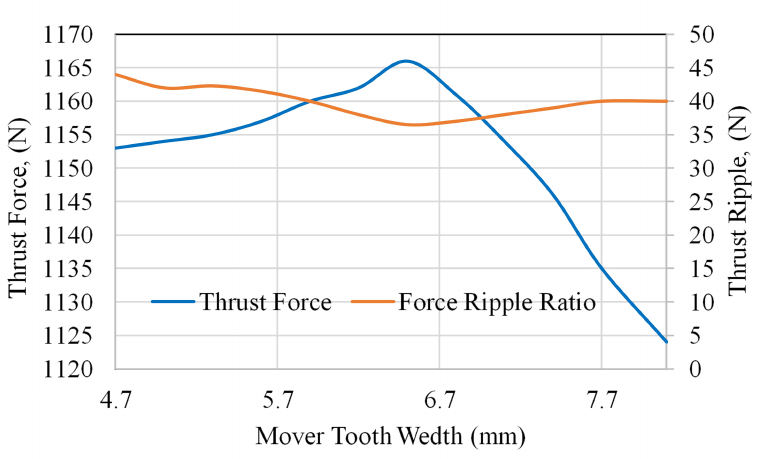
Figure 7. Force ripple and thrust force variation with mover tooth width for dual mover yokeless multi-tooth PMFSM.